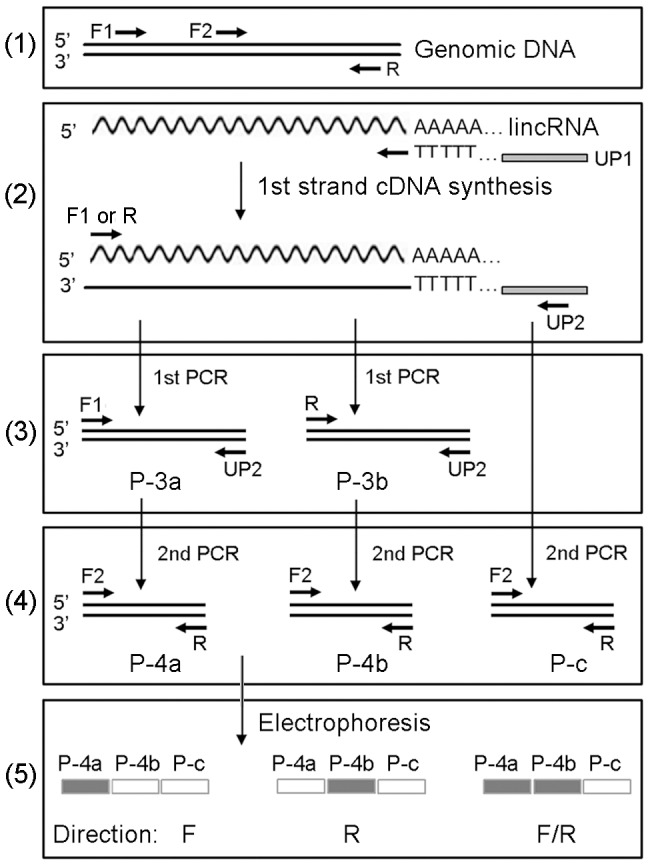
Schematic representation of the MRA method.(1) Relative locations of primers F1, F2, and R on a target locus; (2) First-strand cDNA synthesis using primer UP1; (3) First-round PCR amplification. The gene-specific primer F1 or R was used as the forward primer and primer UP2 was used as the reverse primer, producing PCR products P-3a and P-3b, respectively. The relative positions of the primers on the PCR products are shown; (4) Second-round PCR amplification. The gene-specific F2 was used as the forward primer and R was used as the reverse primer, producing PCR products P-4a and P-4b, respectively. The relative positions of the primers on the PCR products are shown. For the control, the first-strand cDNAs were used as the template, producing products P-c; (5) A graphic representation of the expected electrophoresis results and the corresponding transcriptional orientation they represent. The filled rectangle indicates the presence of a band and the hollow rectangle indicates the absence of a band. The name of the PCR products are the same as described above in (3) and (4). The transcriptional direction determined based on each pattern is shown as F (Forward), R (Reverse) and F/R (bidirectional).